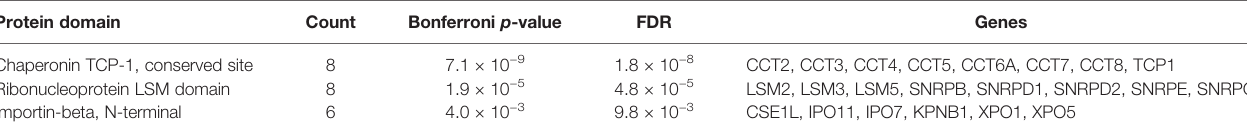
GeneswithexpressioncorrelatingpositivelywithGlo1withcorrelationcoef fi cientr 2 ≥ 0.10wereanalyzedforproteindomainenrichmentanalysis.Forthe340genessubmittedforanalysis, protein domain enrichment analysis was performed by INTERPRO in the Database for Annotation, Visualization and Integrated Discovery v6.8 (https://david.ncifcrf.gov/) (23). Threshold criterion for signi fi cance: FDR